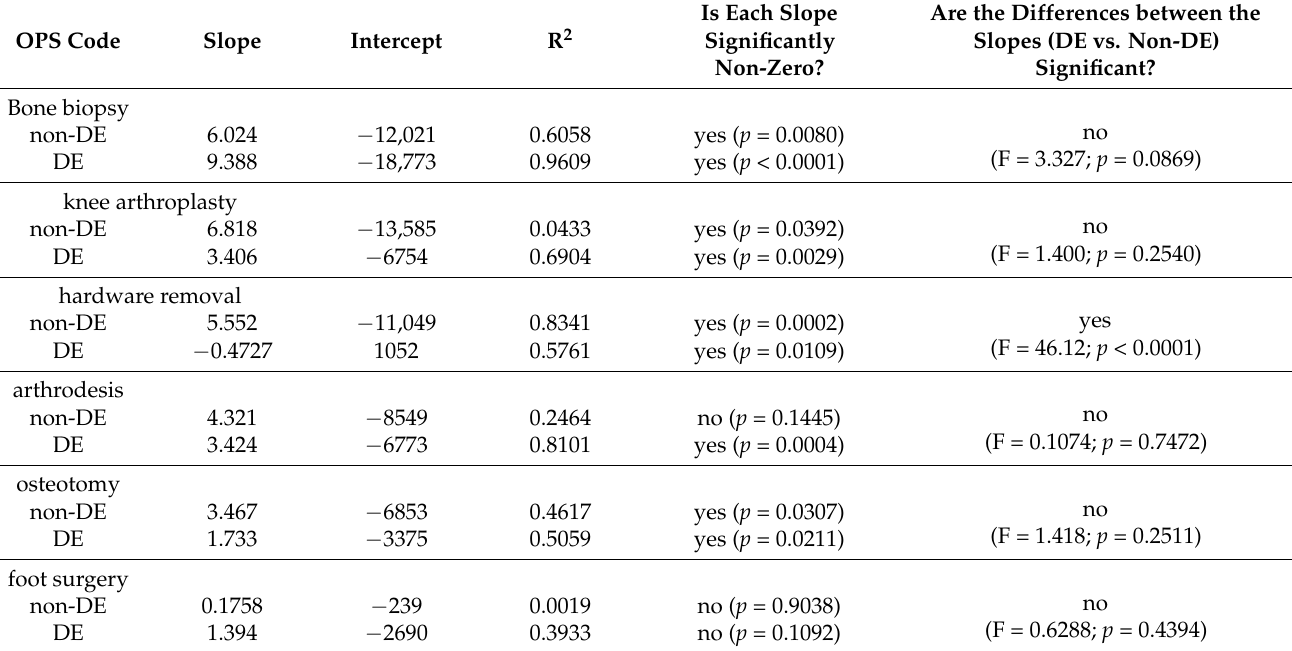
Table 2. Results of the linear regression analysis for both groups (DE and non-DE).